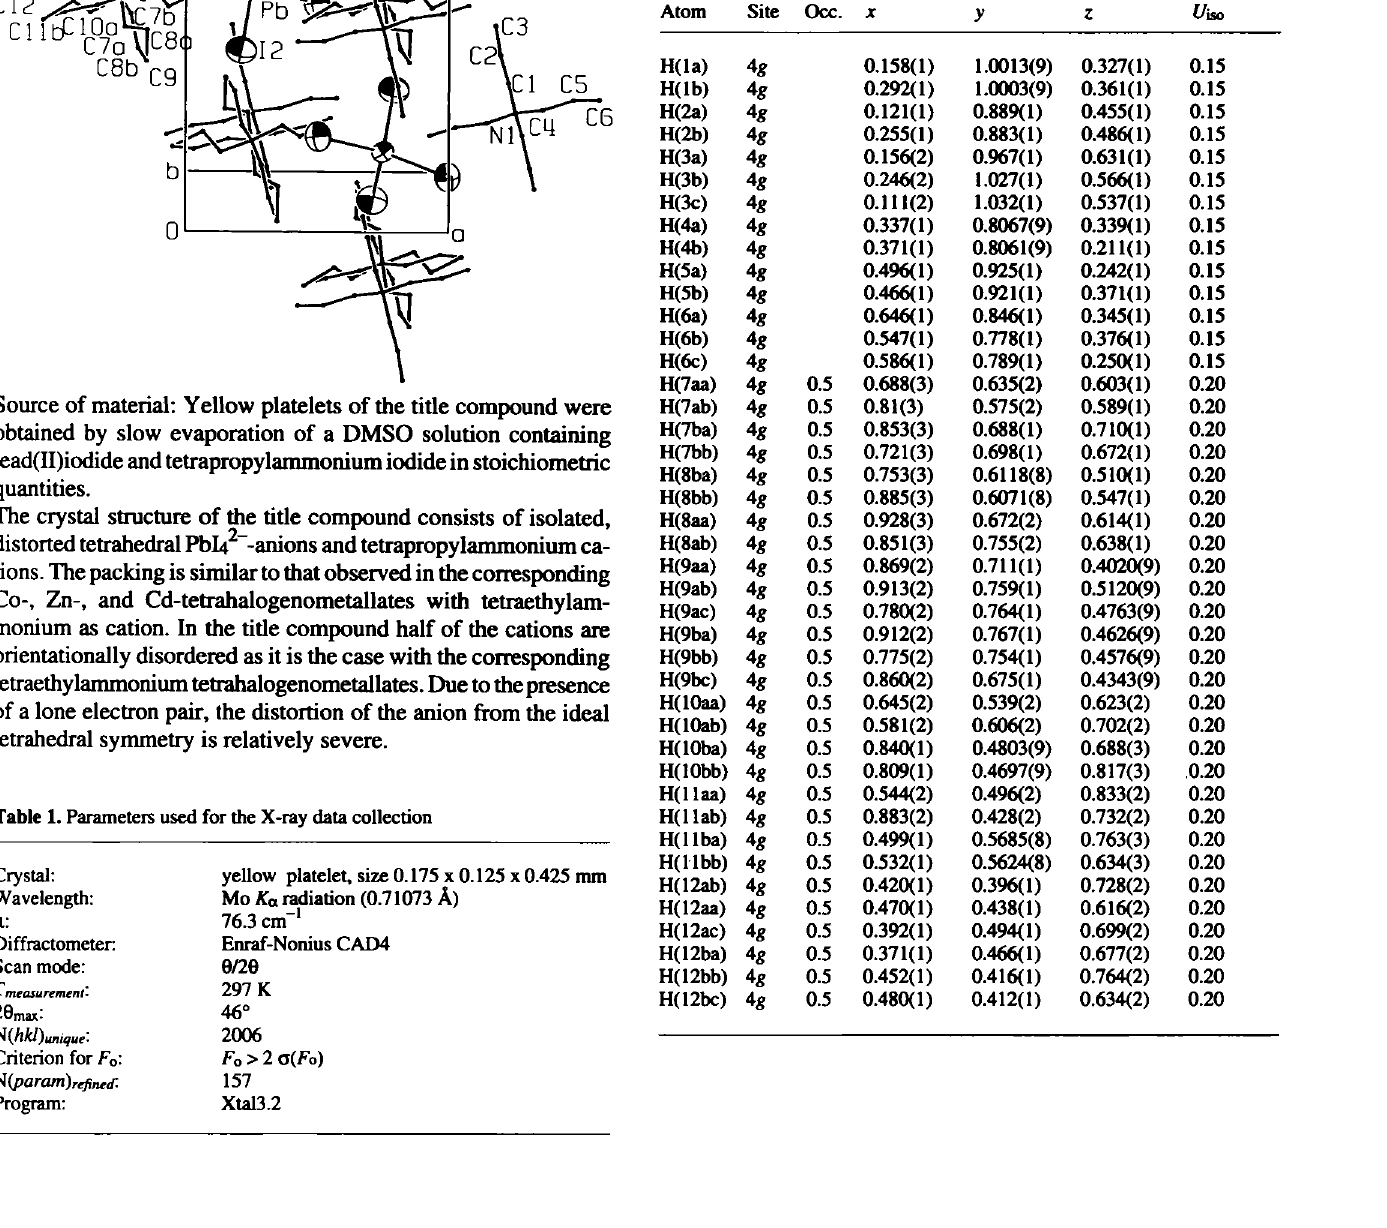
Table 2. Final atomic coordinates and displacement parameters (in A 2